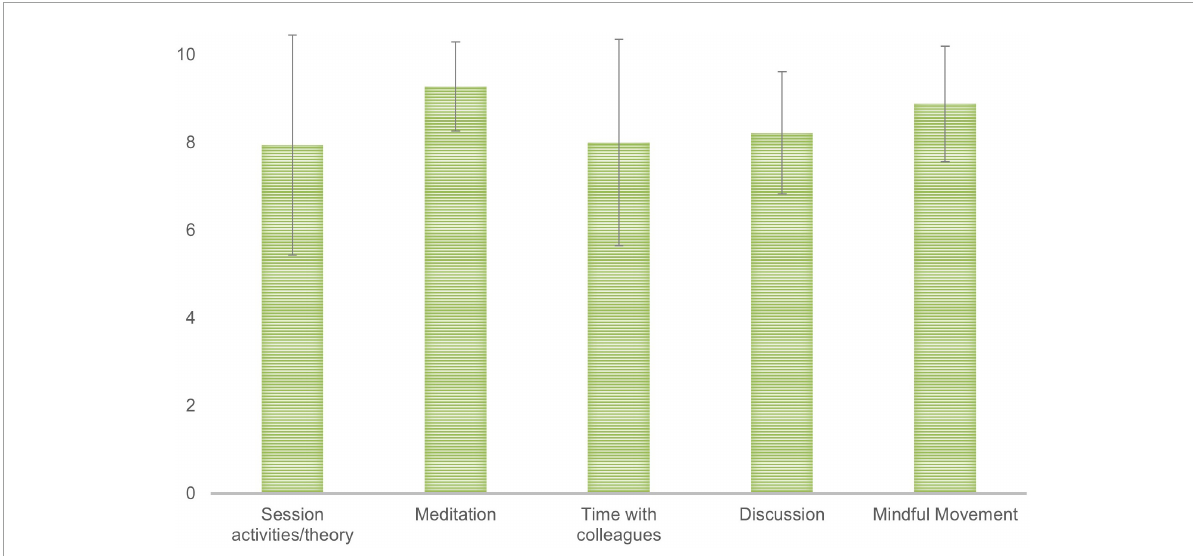
FIGURE3 Participant satisfaction: Ratings of usefulness for the components of the Mindful Practice for Teachers (MPT).